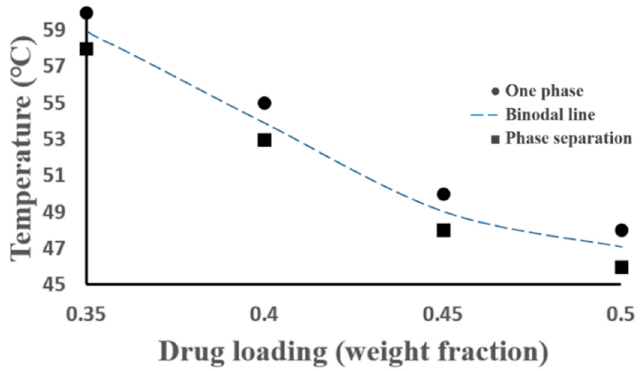
Figure 7. Four experimental points detected for aFD, PVPK15 and water ternary system, the binodal line was the boundary between one phase and AAPS.